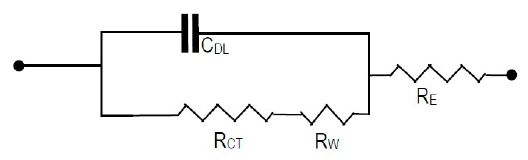
Figure 1. The schematic diagram of the tested battery.